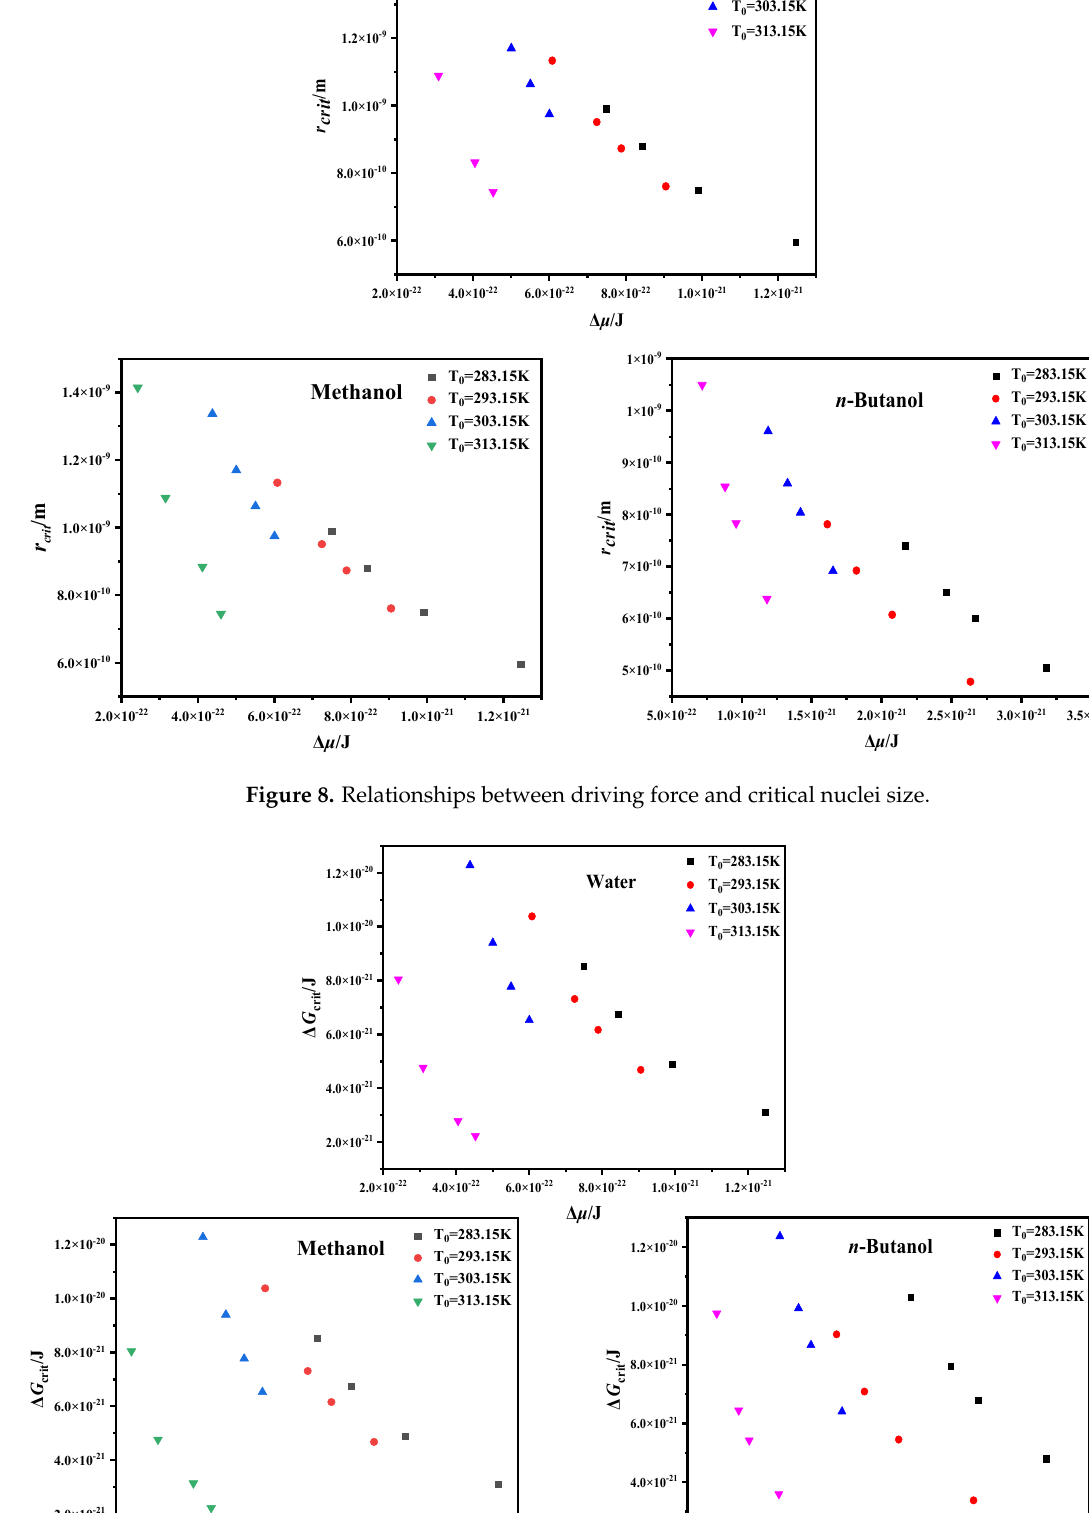
Figure 9. Relationships between driving force and nucleation Gibbs free energy.